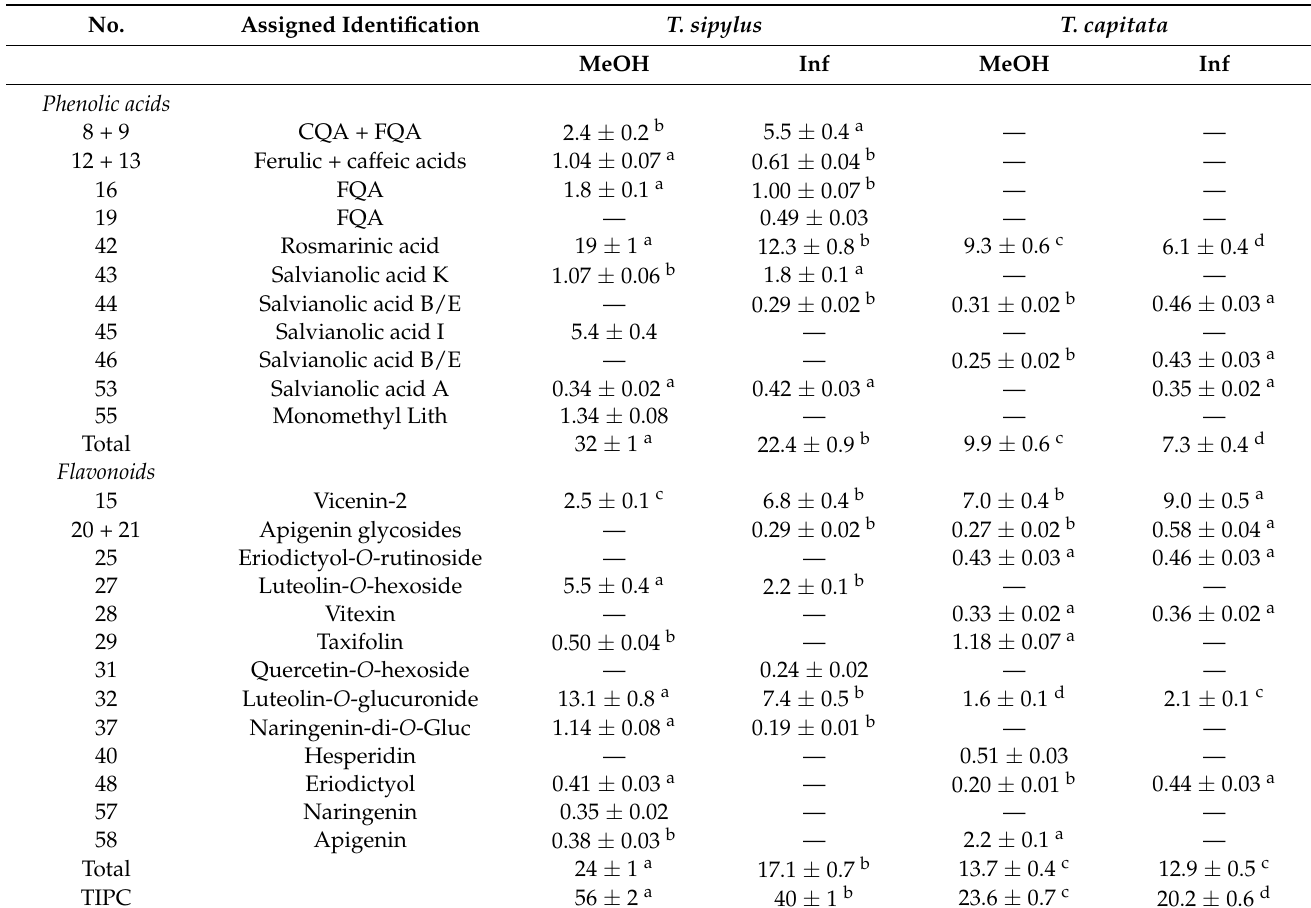
Table 4. Quantification of the main phytochemicals in the analyzed extract of Thymus sipylus and Thymbra capitata (mg g − 1 DE; n =